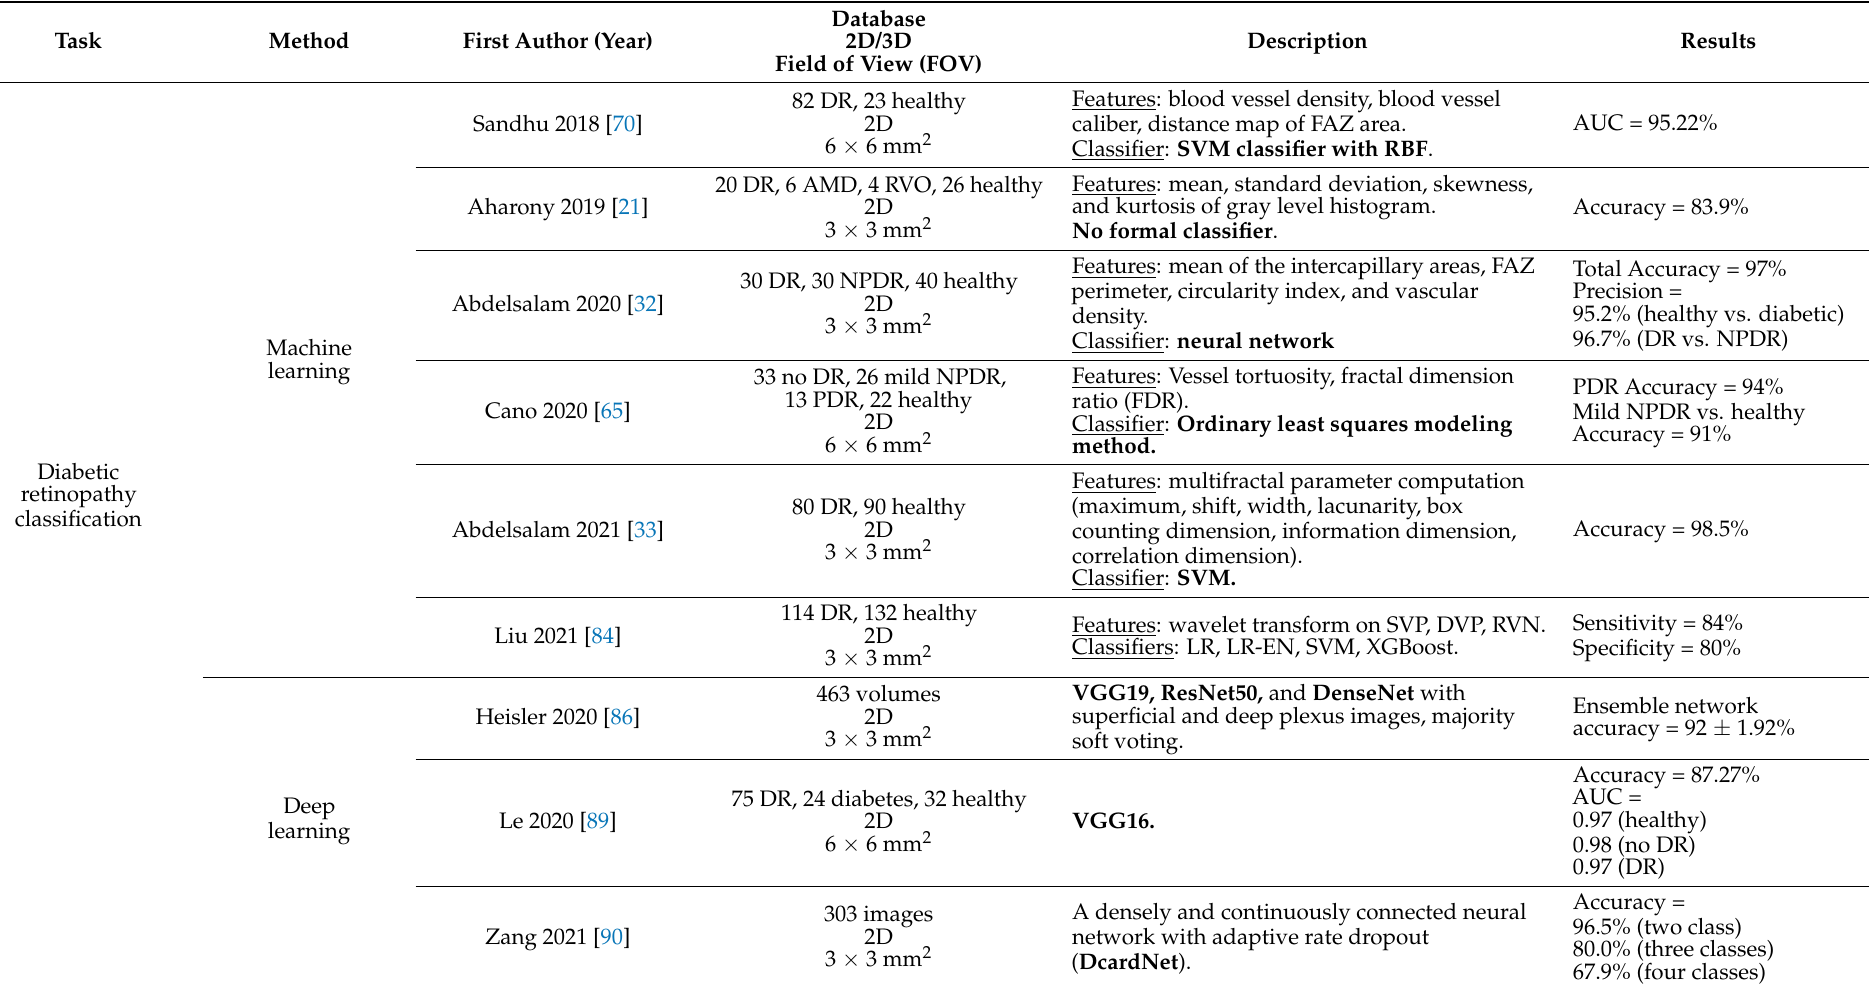
Table 2. Classification tasks